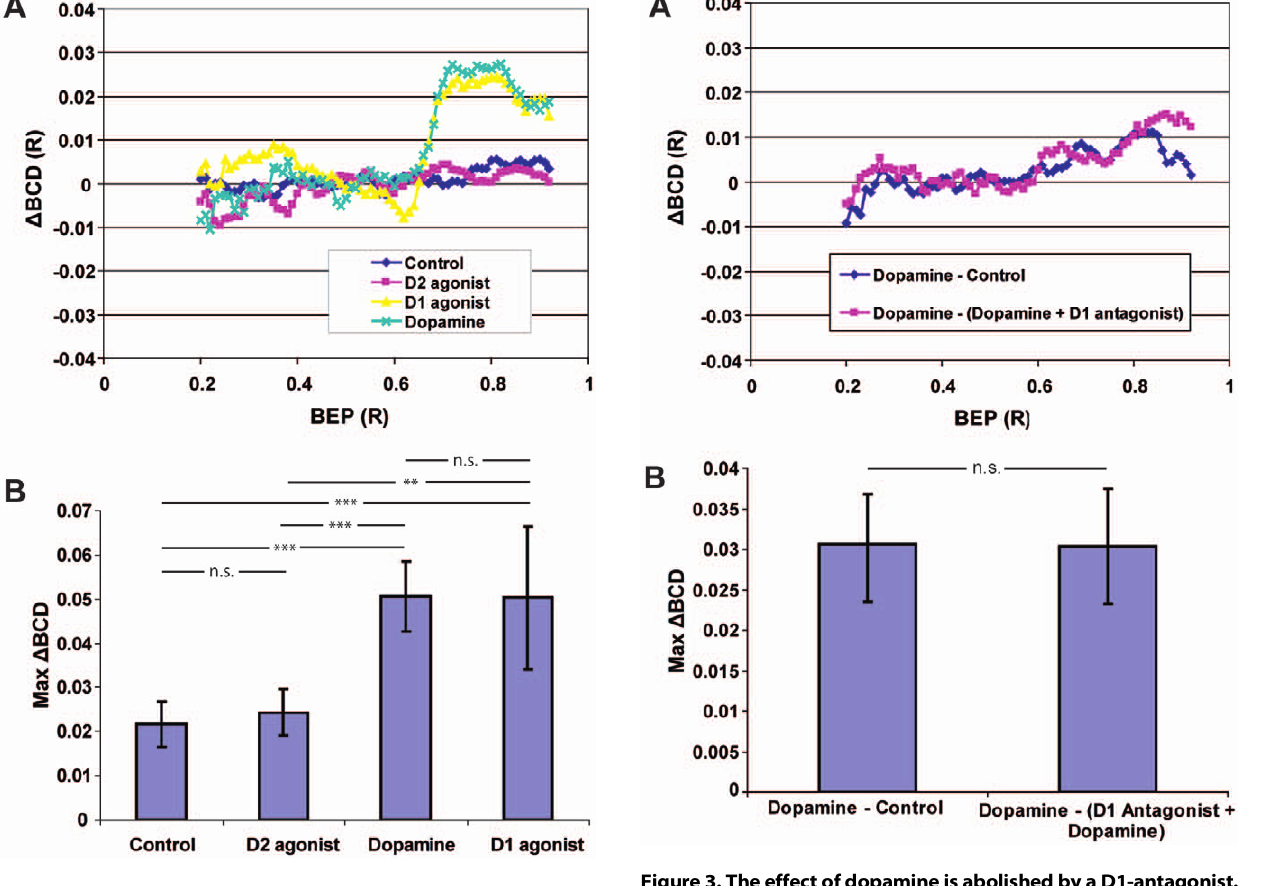
Figure 2. Dopamine and a D1-agonist induce similar changes in lens refractive power. (A) Mean D BCD curves from 31 lens pairs where onelens was treated with dopamine,D1-agonist,or D2-agonist, aswell as pairs where both lenses were untreated (control). Treatment with the D1- agonist SKF-38393 induced an effect similar to that of dopamine in that BCD values increased in the lens cortex, BEP 0.60–0.95. Both treatments thus reduced the refractive power in the cortex compared to untreated lenses. The D2-agonist quinpirole had no effect. The curves represent the mean D BCDs from 31 animals (Control: n=8, D1: n=7, D2: n=7, D: n=9). (B)Max- D BCDvaluesandstandarddeviationinthecontrol andtreatment groups. There was no significant (n.s) difference between max-BCD values from dopamine and D1-agonist treatments or between the control and D2-agonist. **=Significance level 0.01%, ***=significance level 0.001% (n=31).